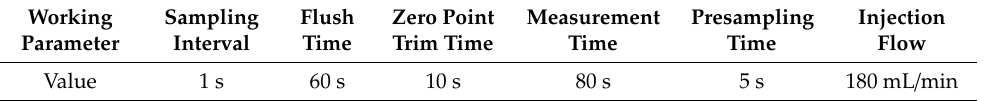
Table 2. The working parameter settings of